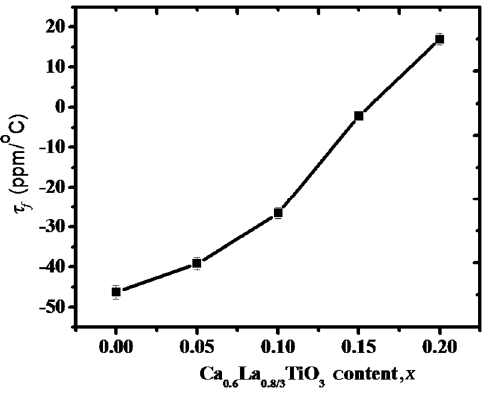
Q f  of  and and r u 0 f  . r